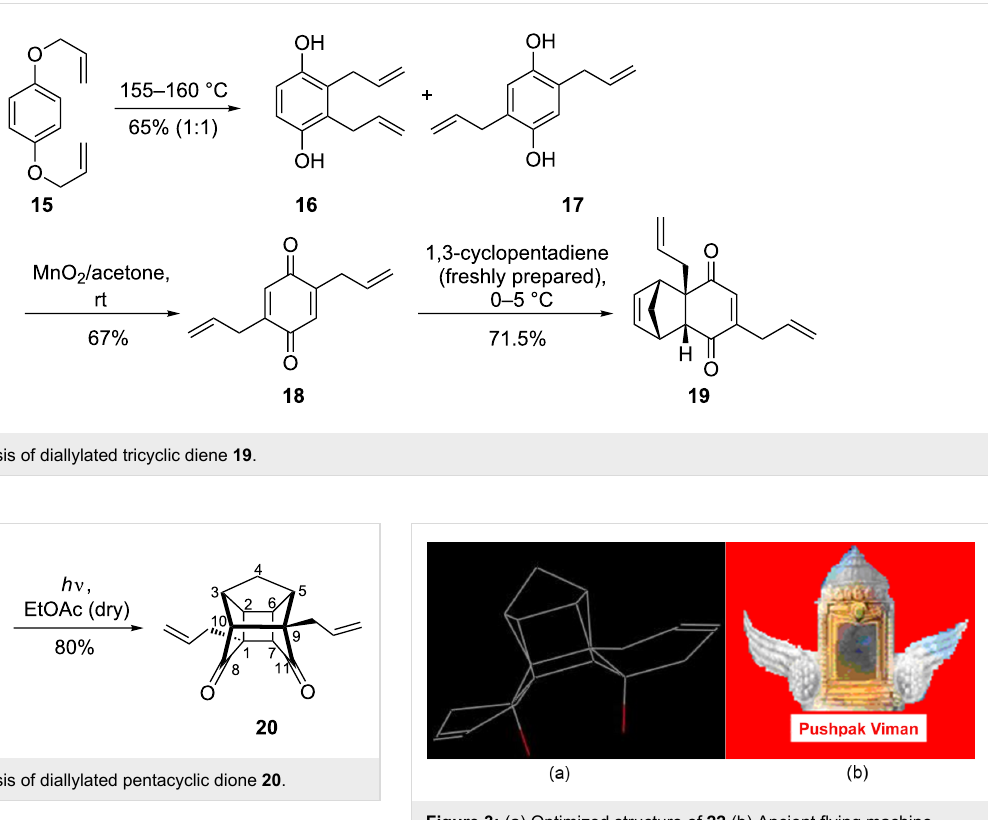
Figure 3: (a) Optimized structure of 22 (b) Ancient flying machine “Pushpak Viman”.